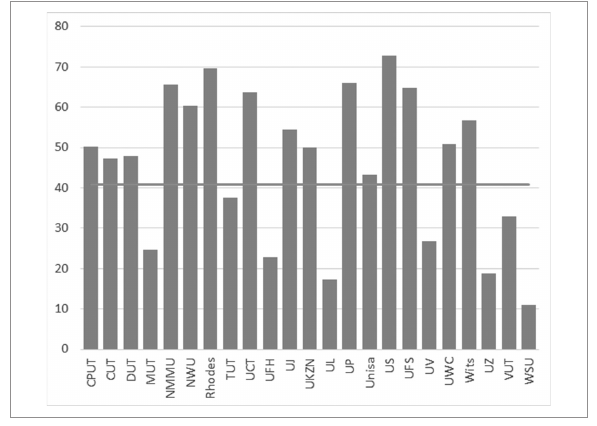
Equity Indices for 23 higher education institutions corrected for errors in the initial formulation, and national Equity Index based on